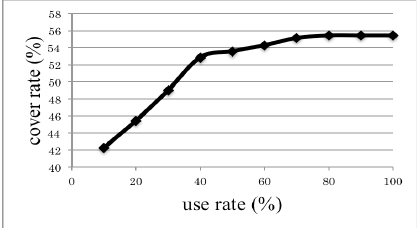
Figure 16. Cover rate by every 10% use of extracted